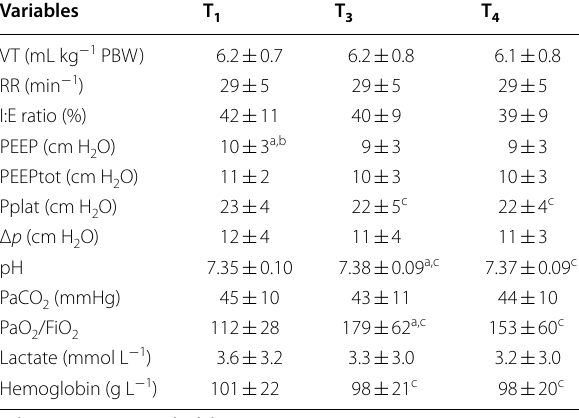
Table 4 Respiratory parameters during prone